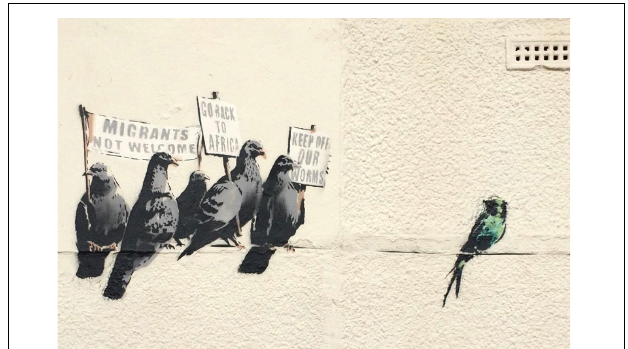
FIGURE 1 | A mural by street-artist Banksy, that was located in Clacton-on-Sea in the Essex district in eastern England, that was removed by the local council due to complaints of being offensive (https://www.bbc.com/news/uk-england-essex-29446232). We highlight here to demonstrate that the concepts of belonging cross-cut species’